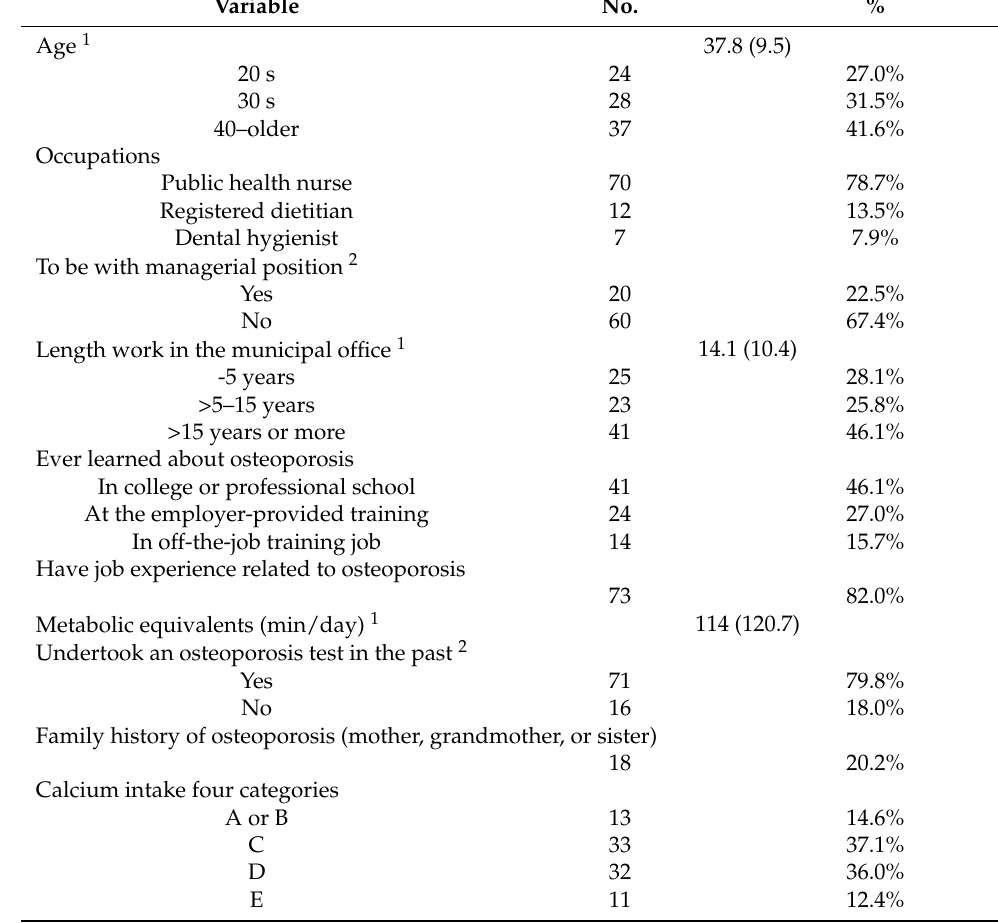
Table 1. Background characteristics of public health professionals in a municipal office in